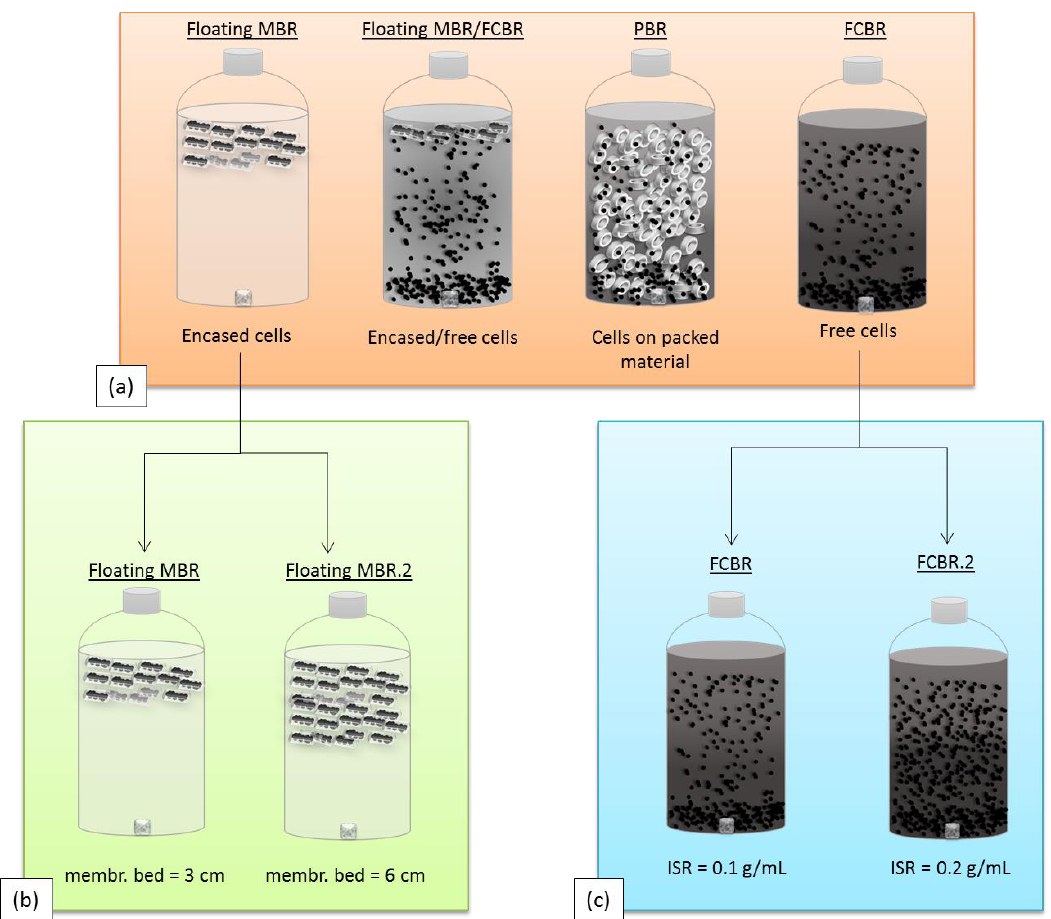
Figure 2. Syngas biomethanation in bioreactors containing ( a ) membrane-encased cells (floating MBR), membrane-encased and free cells (floating MBR/FCBR), free cells growing on packed material (PBR), and free (suspended) cells (FCBR); ( b ) membrane bed thickness of 3 cm (floating MBR) and 6 cm (floating MBR.2), and ( c ) inoculum to syngas ratio (ISR) of 0.1 g/mL (FCBR) and 0.2 g/mL (FCBR.2).